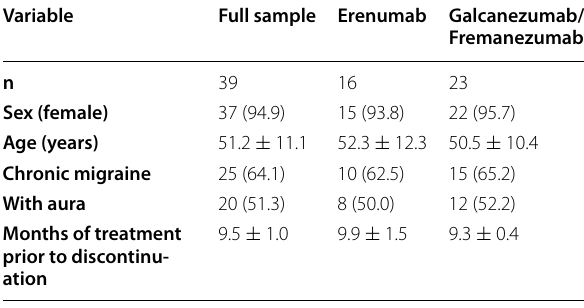
Data is expressed as mean